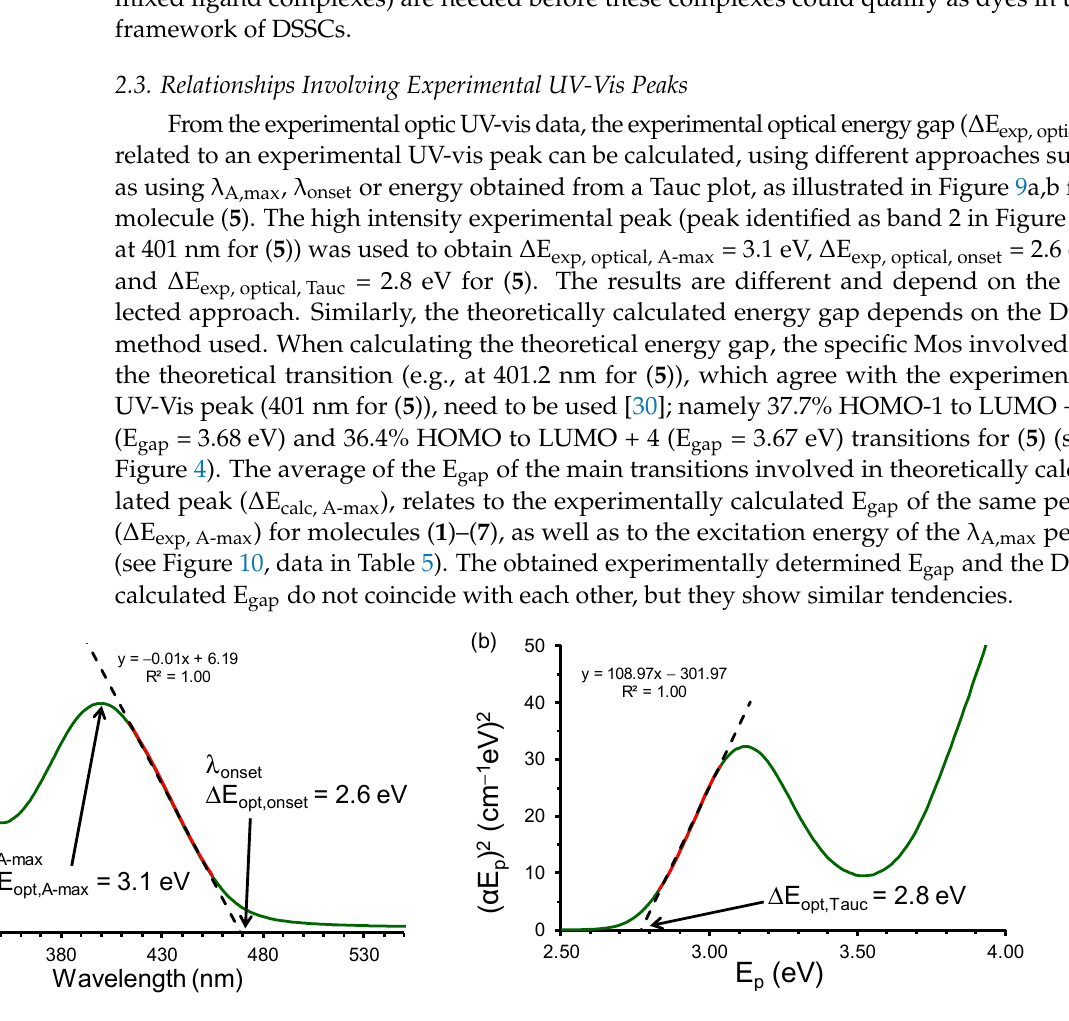
Figure 10. Relationship between experimentally determined optical band gap from the maximum absorbance ( Δ E opt,A-max,exp ) and ( a ) the B3LYP/6-311G(d,p)/def2-TZVPP calculated band gap between the main MOs involved in the electronic transition ( Δ E opt,A-max,calc , average value of E gap as shown in Figure 4 for ( 5 )), ( b ) the excitation energy of the λ A,max peak. (Data in Table 5) Table 5. B3LYP/6-311G(d,p)/def2-TZVPP E gap and experimentally determined E gap (from UV-vis ab- sorbance maximum wavelength λ A,max ). No